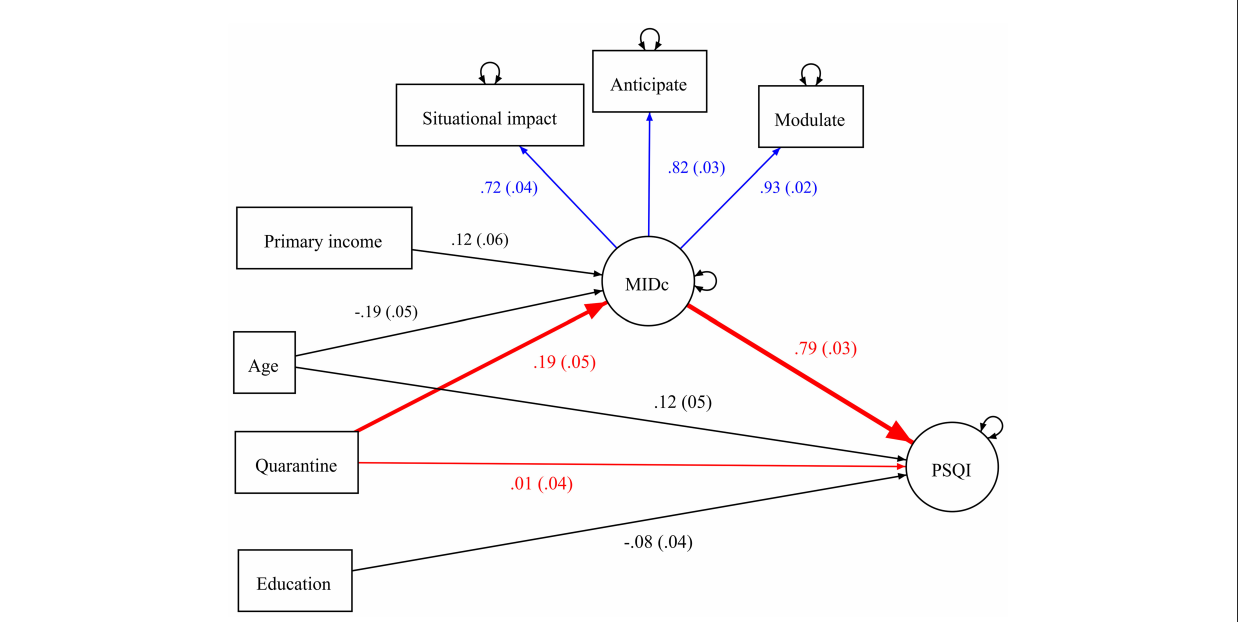
FIGURE1 Standardized coefficients of the structural equation model from quarantine experience to PSQI factor via MIDc factor. PSQI, Pittsburgh Sleep Quality Index; MIDc, Mental Impact and Distress Scale: COVID-19. Standard errors are presented in parenthesis. The blue, black, and red arrows denoted the factor loadings, covariate effects, and main regression paths, respectively. The indirect pathways from quarantine to PSQI via MIDc were highlighted in bold. The seven PSQI observed components and non-significant paths from control variables to MIDc and PSQI were not shown in the figure for the simplicity of